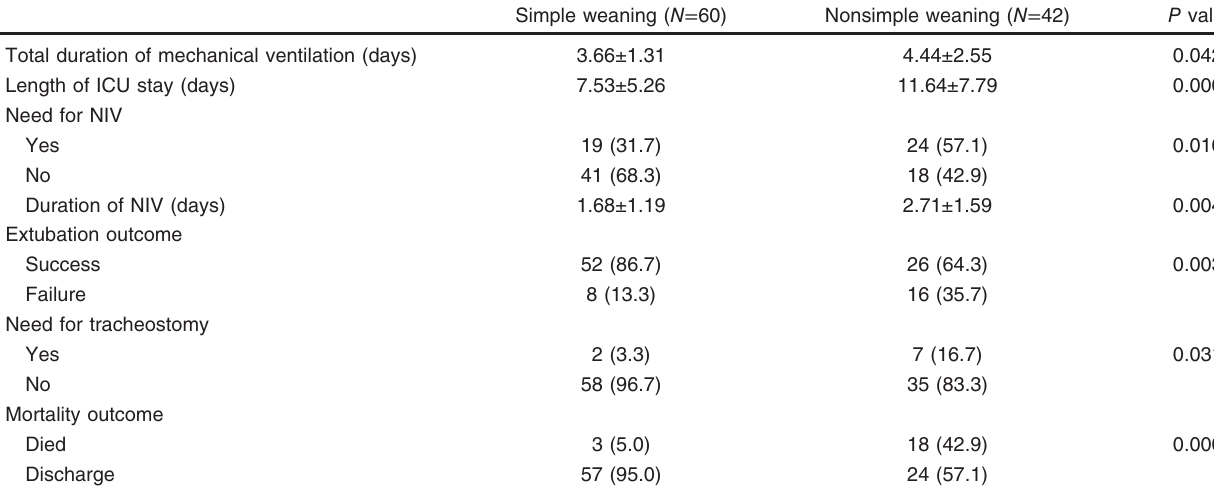
Simple weaning ( N =